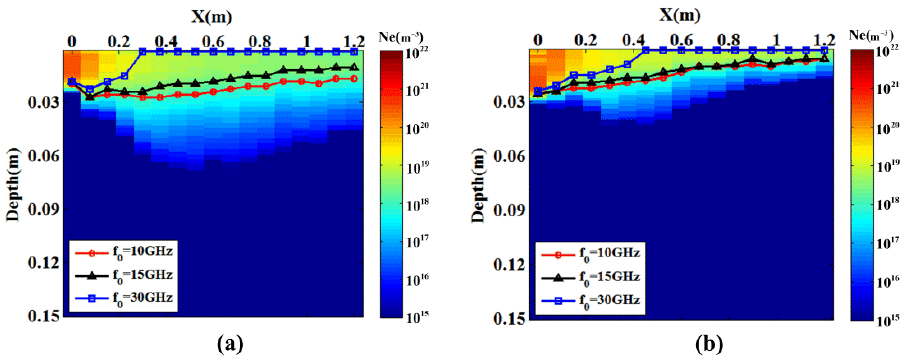
Figure 12. The reflective surface of plasma sheath for scenes 6 and 7. ( a ) Attack angle is 10°. ( b ) Attack angle is 20°.